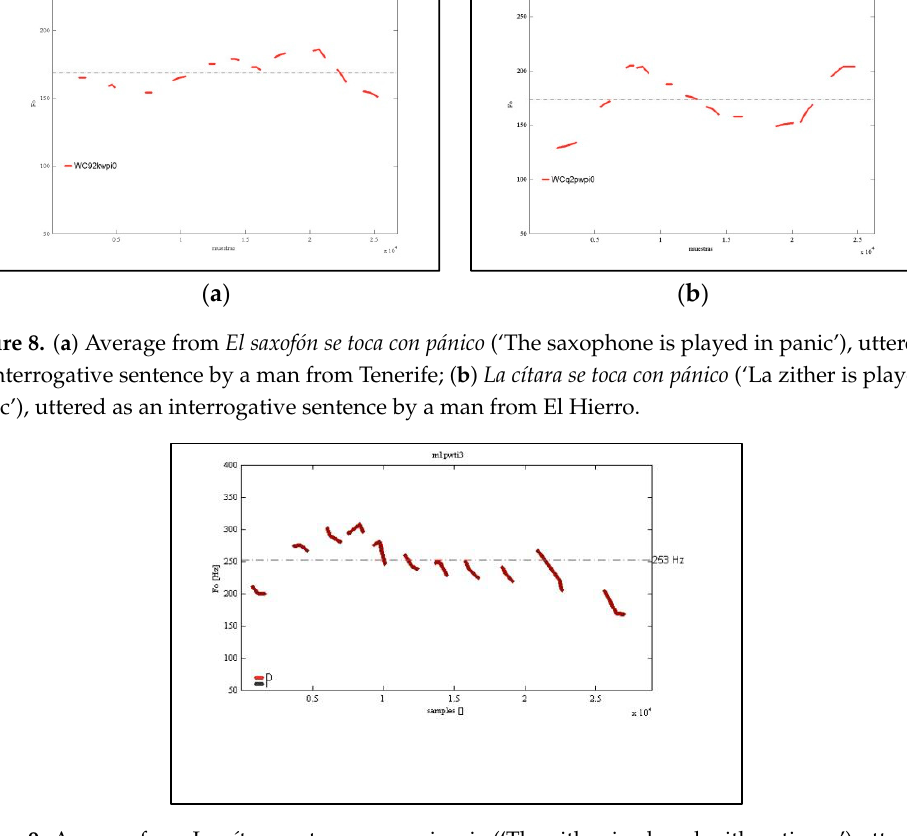
Figure 9. Average from La cítara se toca con paciencia (‘The zither is played with patience’) uttered as an interrogative sentence by a woman from La Palma.